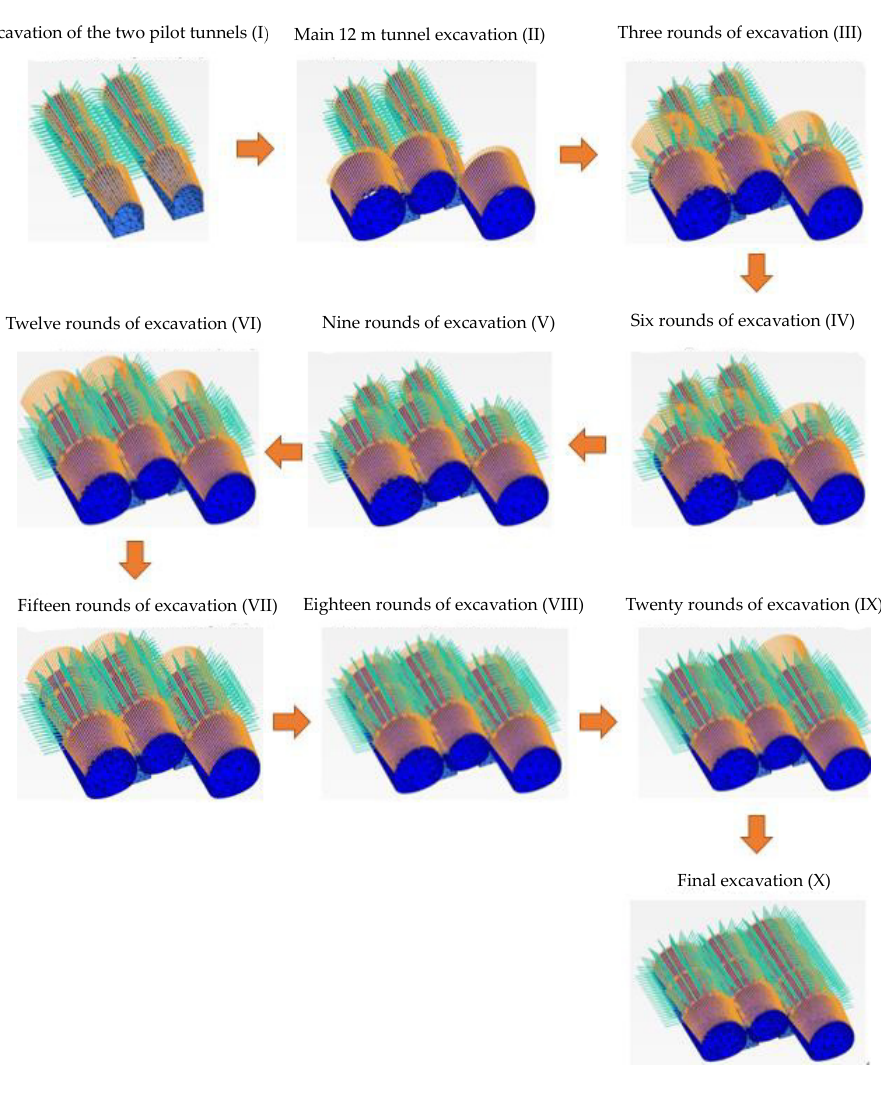
Figure 13. Tunnel excavation at different stages.